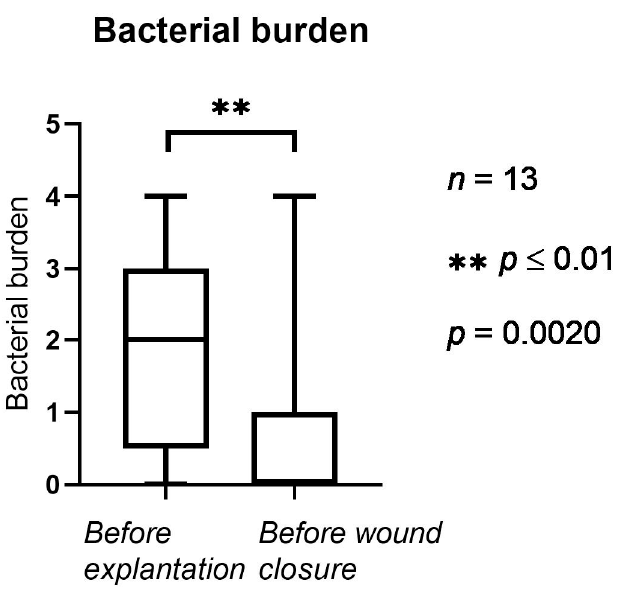
Figure 3. Bacterial burden in the implant pocket (1: sparse, 2: moderate, 3: several, 4: plenty). The horizontal lines mark the medians.